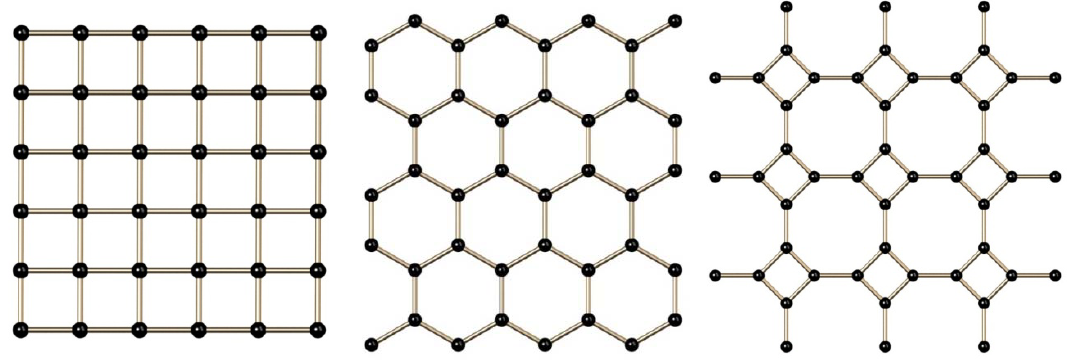
Figure 2. Topology of the uninodal two-dimensional coordination